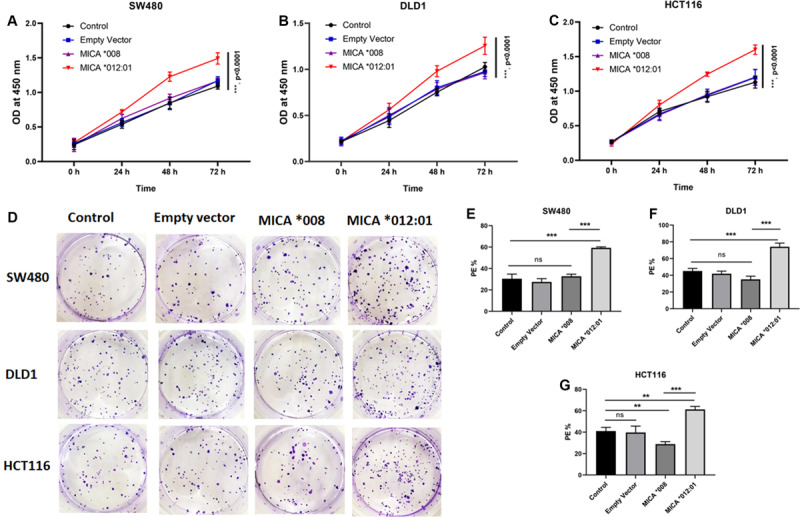
Cell proliferation and colony forming assays of KRAS mutated CRC cell lines with expression of MICA *012:01 or MICA *008 allele. Growth curves were examined by CCK-8 assay in (A) SW480 cells, (B) DLD cells, and (C) HCT116 cells. (D) The proliferative capability of MICA alleles was determined by cell clone formation experiments with corresponding histograms shown in (E–G). Cell colony-formatting efficiency was calculated as: PE (Planting efficiency)% = Cell clone/Inoculation cell number × 100%. Control, untransfected cells; Empty vector, cells transfected with pEGFP-C3 plasmid vector; MICA *008, cells transfected with pEGFP-MICA *008 recombination vector; MICA *012:01, cells transfected with pEGFP-MICA *012:01 recombination vector. ns, no significance; *p < 0.05; **p < 0.01; ***p < 0.001.